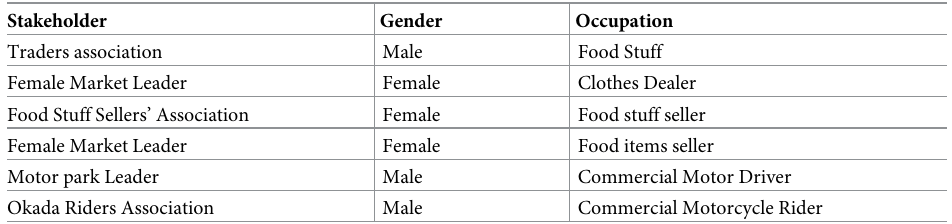
Table 1. Socio-demographic of key informants interviews